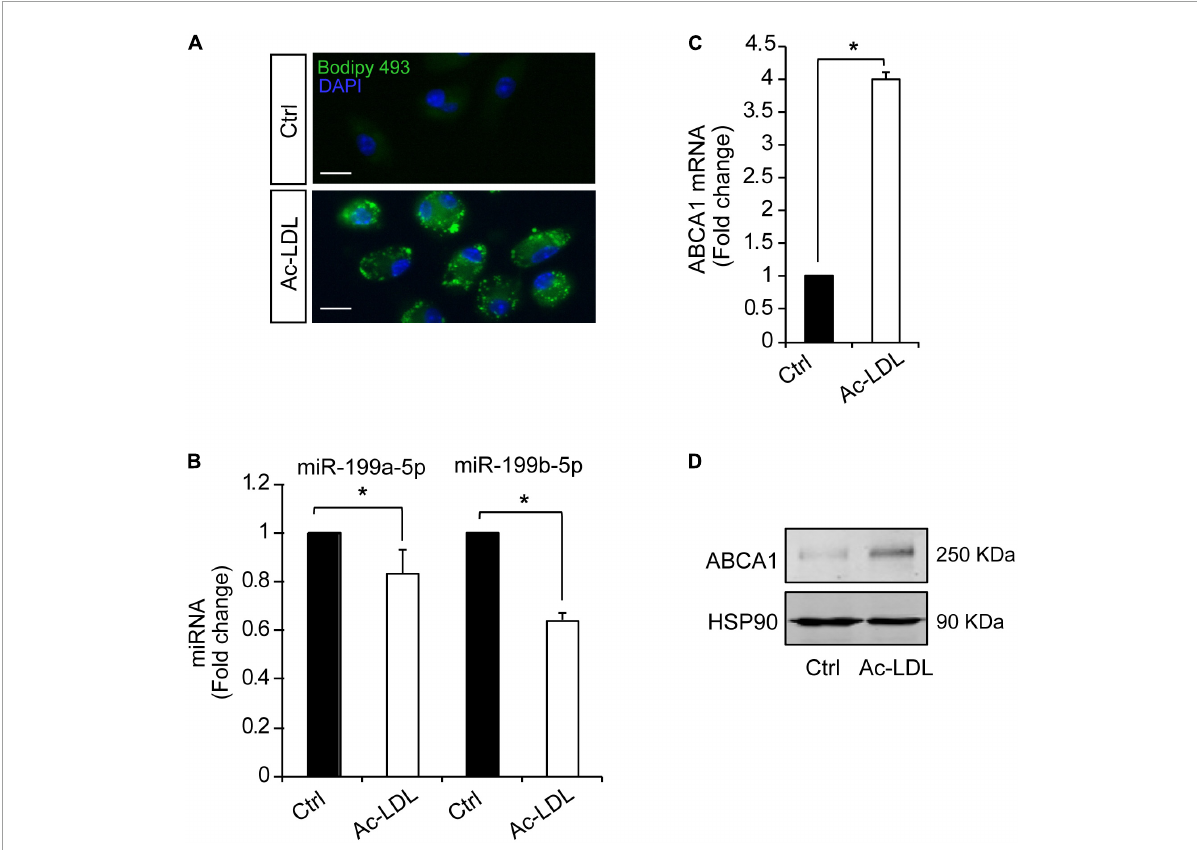
FIGURE4 Cholesterol loading in peritoneal macrophages downregulates miR-199a-5p and upregulates ABCA1. (A) Representative images showing lipid droplets in mouse peritoneal macrophages treated with Ac-LDL for 24 h and stained with Bodipy 468 (green). Nuclei were stained with DAPI (blue). These experiment were performed 3 independent times. Scalebar: 10 µ m. (B,C) qRT-PCR analysis of miR-199a-5p, miR-199b-5p (B) and Abca1 (C) , expression levels in mouse peritoneal macrophages stimulated with Ac-LDL (120 µ g/mL) for 24 h. Data are expressed as relative expression levels and correspond to the means ± SEM from three independent experiments performed in triplicate. * P < 0.05, significantly different from control (Ctrl) cells. (D) Representative Western blot of ABCA1 in mouse peritoneal macrophages stimulated with Ac-LDL. HSP90 was used as a loading